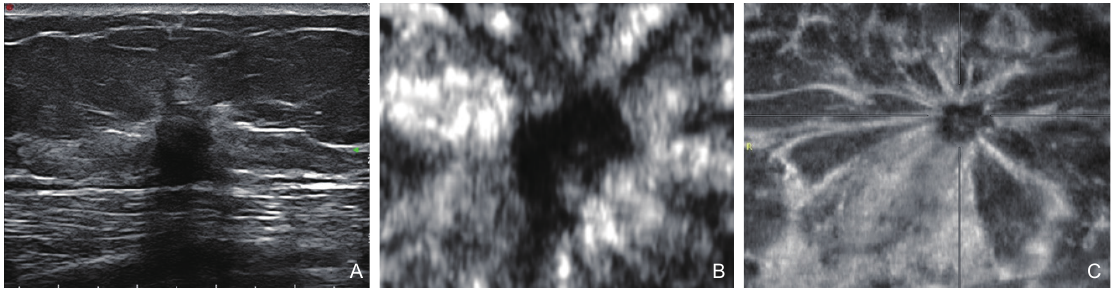
Figure 2 A 62-year old woman with invasive ductal carcinoma in the right breast. (A) Conventional ultrasound showed a hypoechoic lesion (15.5 × 10.5mm) with an irregular shape, spiculated margin, and posterior shadowing, and the final category was BI-RADS 4C for US. (B) 3D-US images displayed the retraction phenomenon in the coronal plane, the final BI-RADS category remained as BI-RADS 4C; (C) ABVS images showed the retraction phenomenon in the coronal plane, the final category was BI-RADS 4C. BI-RADS, breast imaging reporting and data system; US, ultrasound; 3D-US, three- dimensional US; ABVS, automated breast volume scanner.